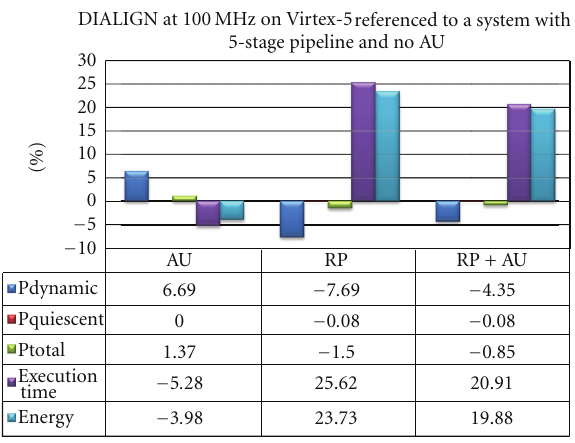
Figure 29: Impact of the MicroBlaze configurations for the DIALIGN algorithm.